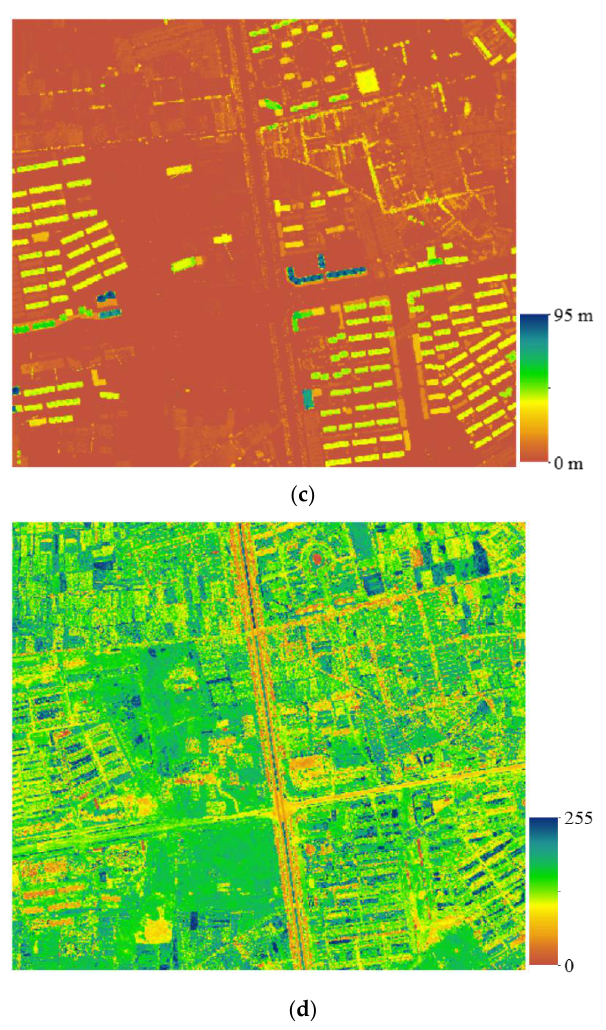
Figure 2. Four LiDAR-derived raster images with 1 m spatial resolution: ( a ) digital surface model (DSM), ( b ) digital terrain model (DTM), ( c ) normalized digital surface model (nDSM), and ( d ) normalized LiDAR intensity image.